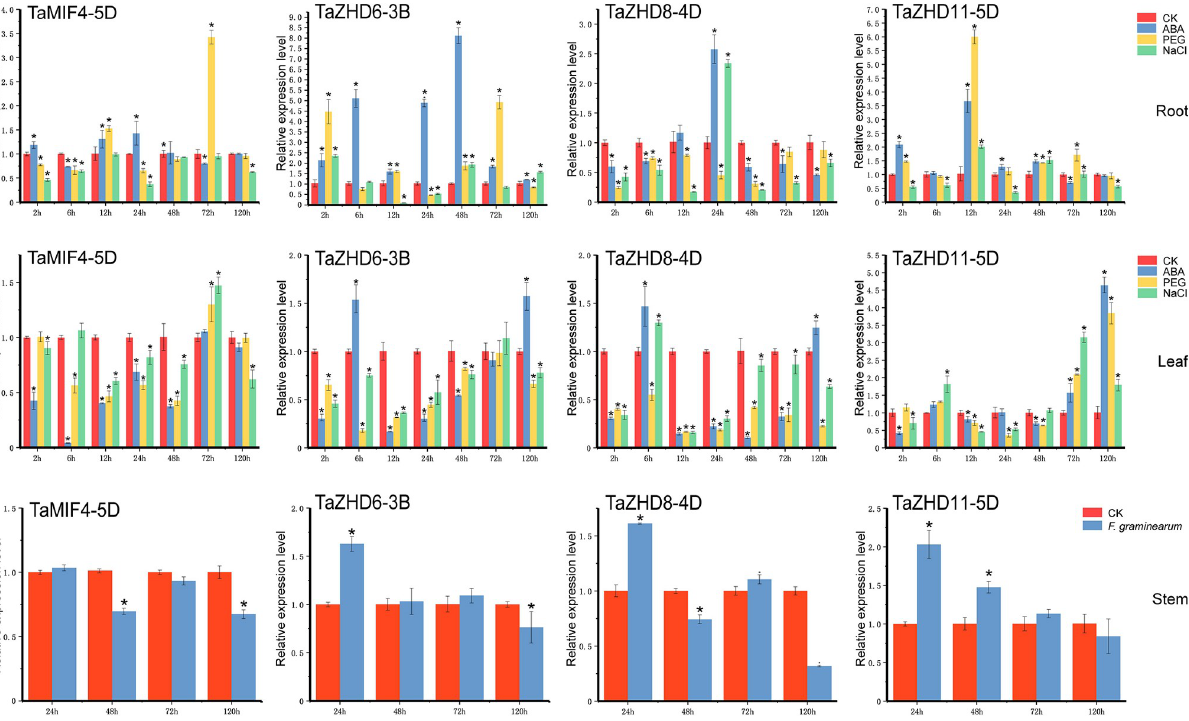
Fig 7. qRT-PCR analysis of TaZF-HD genes under biotic/abiotic stresses. The data were analyzed by three independent repeats, and standard deviations were shown with error bars. The expression level of TaZF-HDs genes was drawn using Origin software. � indicates significant differences that compared with control at p <